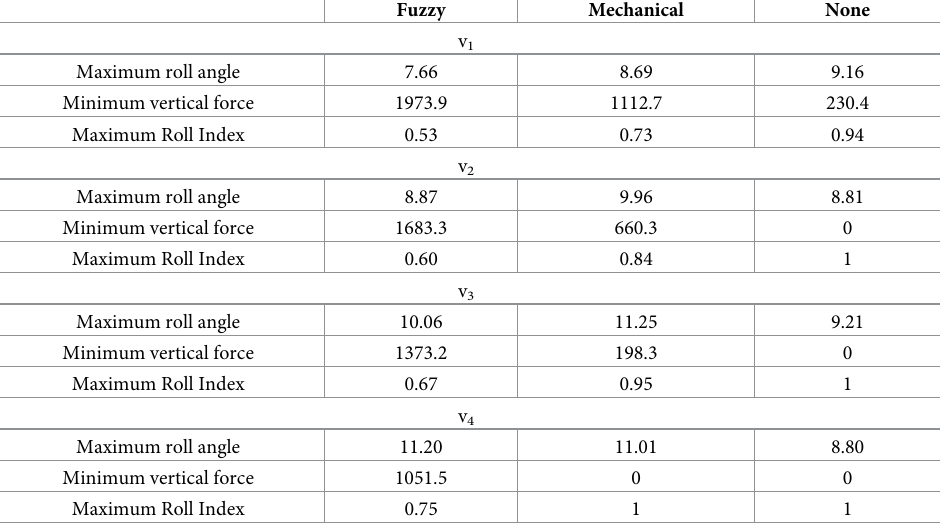
Table 6. Simulation results–Case